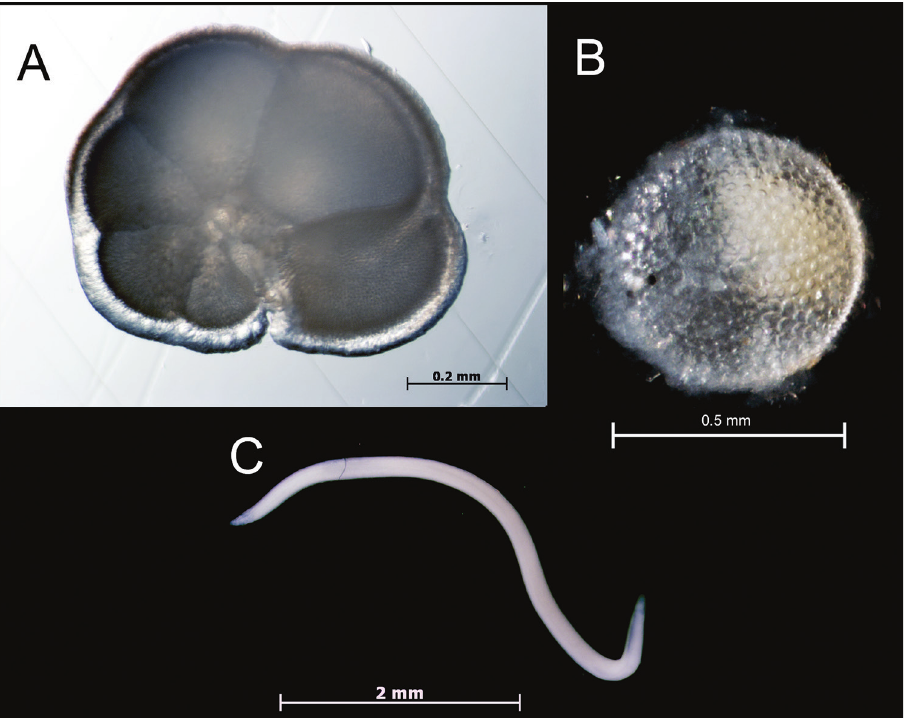
Figure 11. Items from stomachs of deep-reef Lipogramma : A Planktonic foraminiferan, possibly Glob- orotalia manardii, from L. evides, USNM 434771, collected at 174 m B Diatom, possibly Coscinodiscus eccentricus , from L. levinsoni sp. n. , USNM 406140, collected between 137 and 146 m C Parasitic Nema- toda from same specimen as B . Photos by A. Nonaka and L.